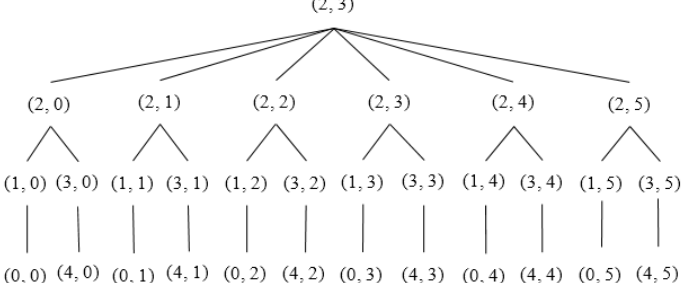
Figure 9. Tree rooted at 13th Sector ( 2, 3 ).